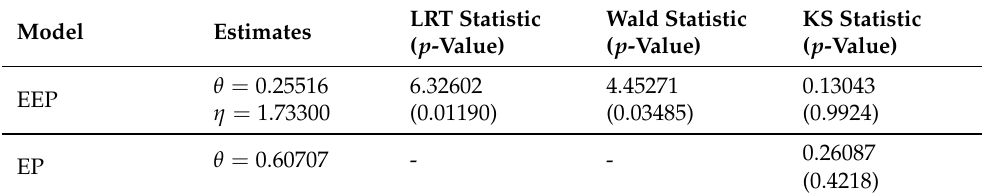
Figure 7. TTT plot ( left ) and box plot ( right ) of the second reactor pump data set. Table 3. Summary of the EEP and EP fit to the second reactor pump data set.